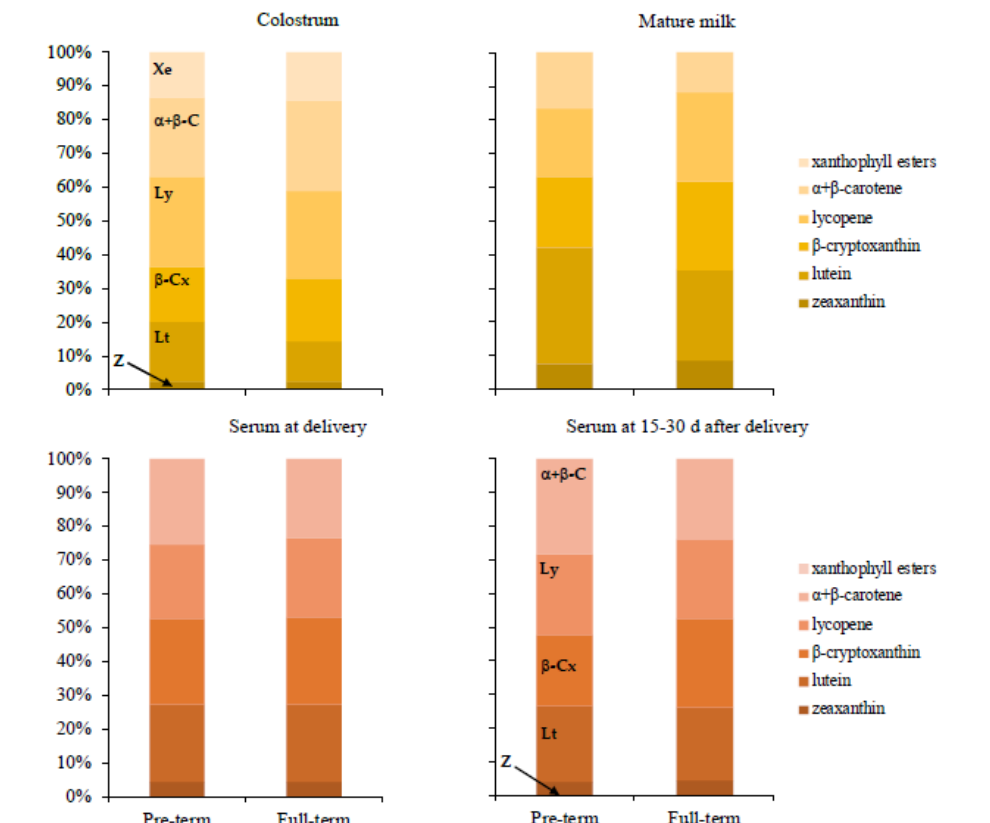
Figure 1. Percentage distribution of the individual carotenoids and xanthophyll esters in colostrum and mature milk samples, and in serum collected at delivery or at 15–30 days after delivery, from preterm and full-term mothers. Xe: xanthophyll esters; α+β-C: α+β-carotene; Ly: lycopene; β-Cx: β-cryptoxanthin; Lt: lutein; Z: zeaxanthin.